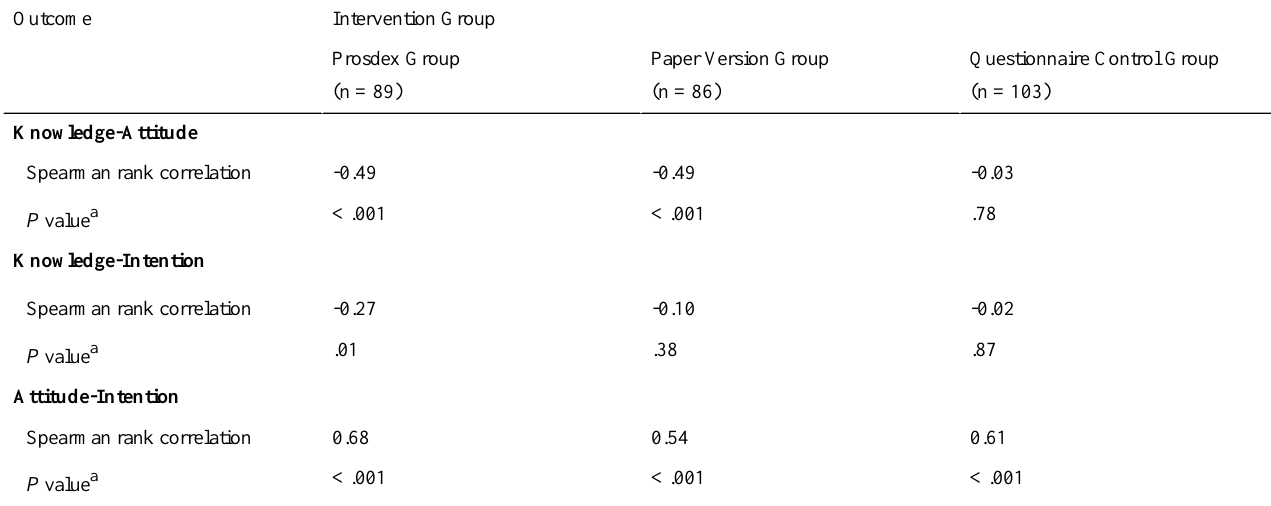
Table 3. Correlation of knowledge, attitude, and intention outcomes for the Prosdex, paper version, and questionnaire control groups Intervention